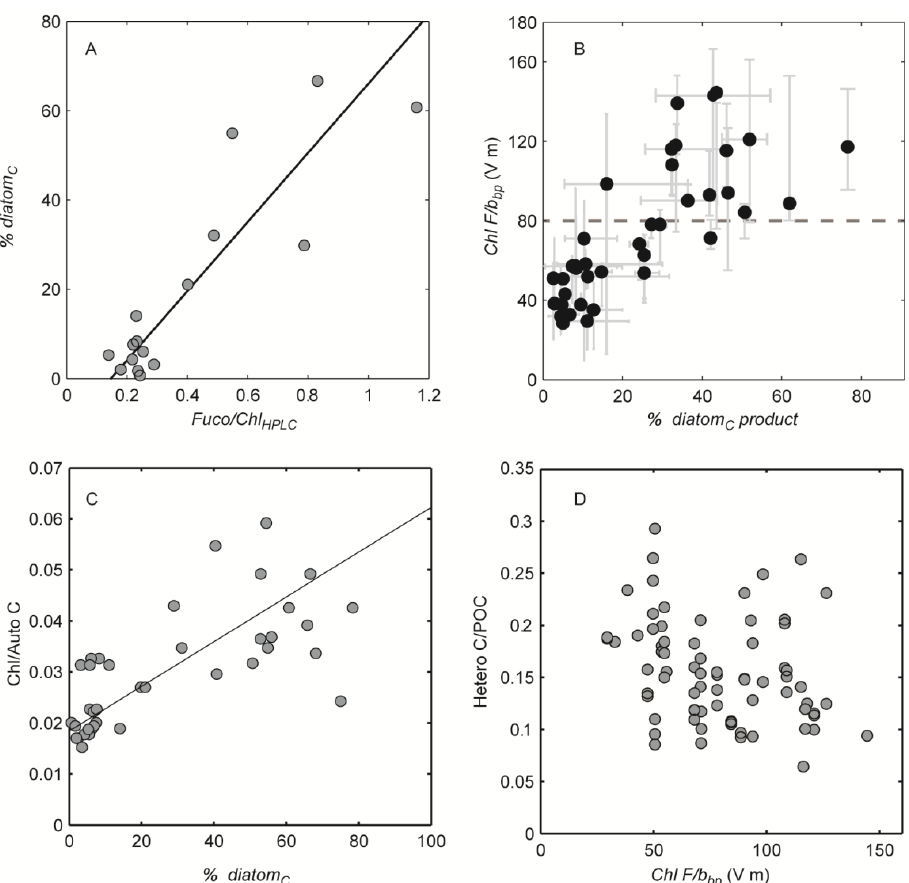
Figure 5. Community composition. Gray circles in panels (a) , (c) and (d) are for individual water samples; black circles in panel b are averages for each profile. (a) Fuco / Chl HPLC ( g/g ) is correlated with % diatom C . (b) Optical community index is related to phytoplankton community composition, represented as % diatom C product. Bars are the range of individual values within each profile; horizontal line indicates the division between Groups 1 and 2 based on Fig. 4b. (c) Chl-to-autotrophic carbon increases with the fraction of diatoms. (d) Ratio of heterotrophic carbon biomass to total POC is not correlated with optical community index.